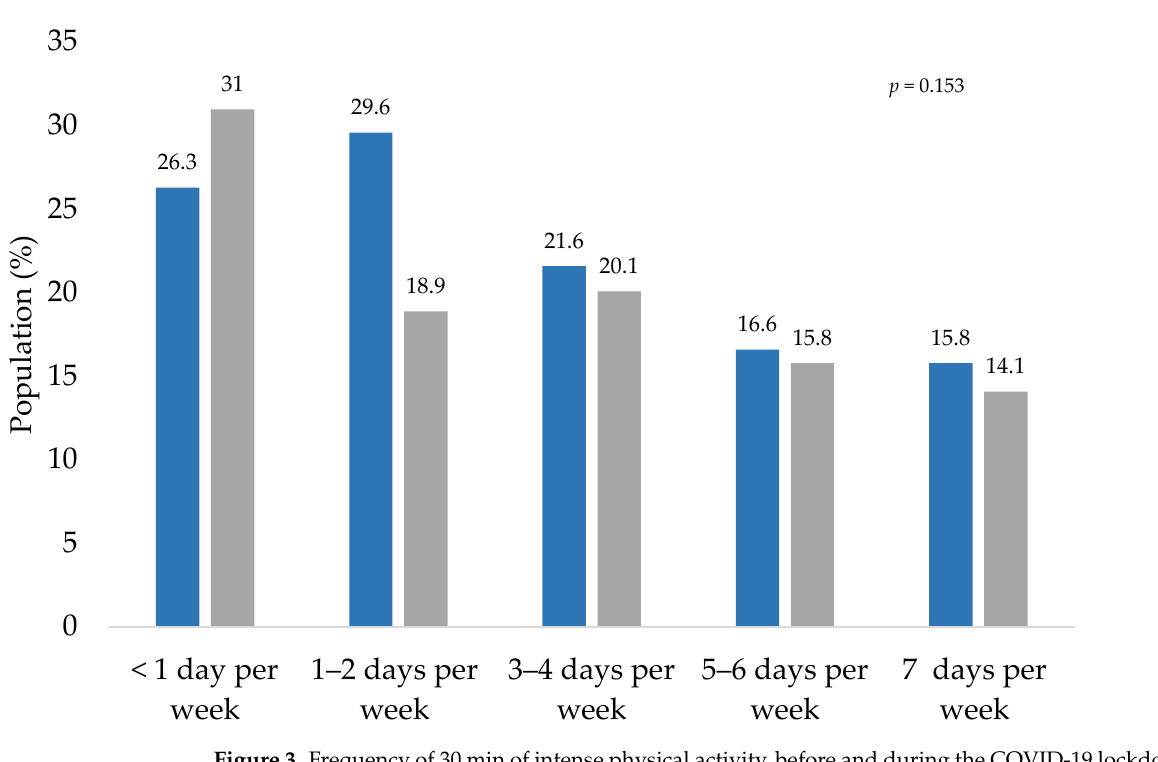
Figure 3. Frequency of 30 min of intense physical activity, before and during the COVID-19 lockdown. Blue bars represent the activity of participants before the lockdown and gray bars represent the activity during the lockdown. The p -values indicate the statistical significance of McNemar test.